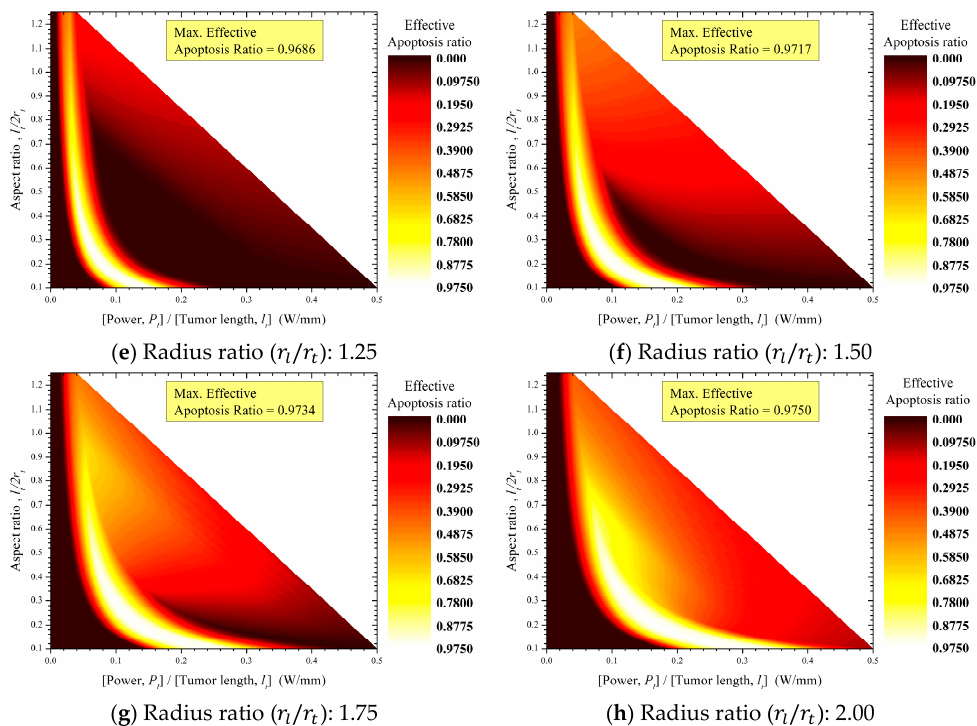
Figure 12. Contour graphs of the apoptosis ratios in tumor tissues with respect to the thermal hazard values of normal tissues.